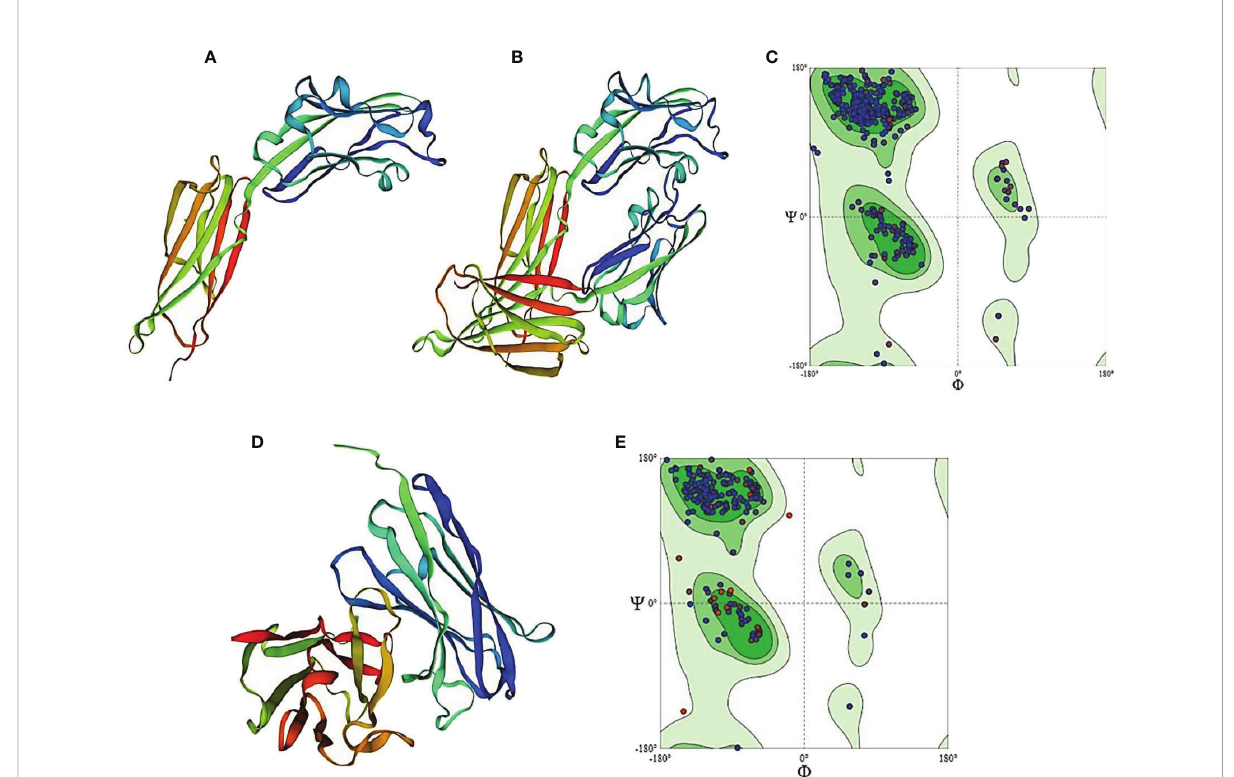
FIGURE 8 Homology model of PD-L1 antigen and antibody generated by Swiss-Model Homology Modeling. (A) represents PD-L1 monomer, (B) indicates homo-dimer of PD-L1, and (C) shows Ramachandran plot for PD-L1 protein. (D) shows homology model of anti-PDL1 scFv generated by SWISS model. (E) represents Ramachandran plot for scFv-PDL1